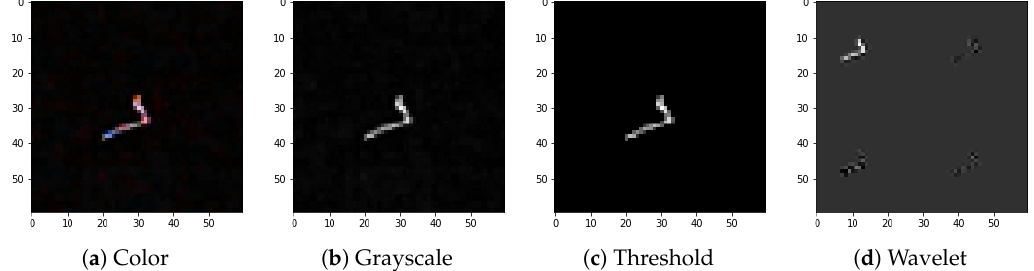
Figure 6. Preprocessing flow: ( a ) color input image, ( b ) grayscale accumulation, ( c ) adaptive thresholding, ( d ) wavelet transformation. Example of the worm-type image.